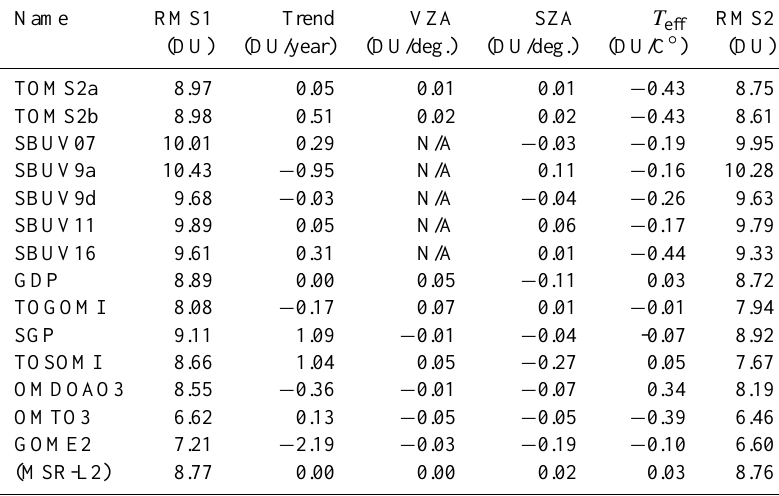
Table 2. Regression coefficients (expressed as corrections) for the various ozone datasets. The columns are (1) Name; (2) RMS original data; (3) Trend correction; (4) Viewing zenith angle correction, (5) Solar zenith angle correction; (6) Effective ozone temperature correction; (7) RMS after application of these corrections.